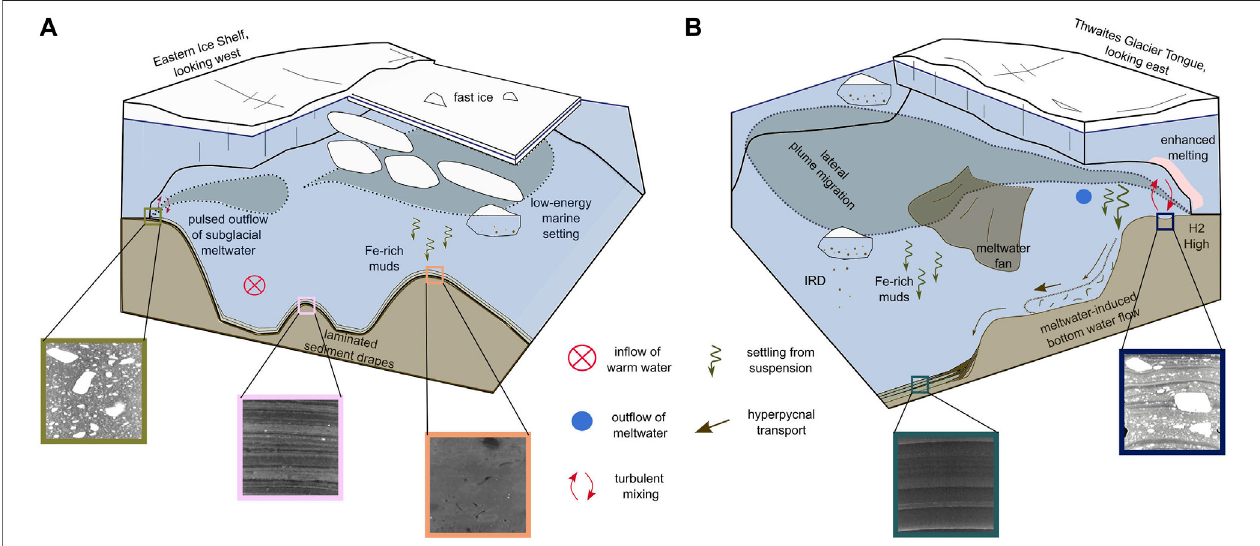
FIGURE 9 | Cartoon of contrasting meltwater drainage styles inferred offshore from the EIS and TGT. Callouts show general depositional settings, not exact locations, of sediment facies presented in Figure 6 . Grounding-line positions are not exact. (A) Persistent, low-magnitude drainage emanating from beneath eastern Thwaites Glacier. Settling from suspension dominates here, likely beneath a perennial canopy of fl oating ice. (B) Downslope gravitational transport sourced from sediment-laden meltwater plume deposits. Hyperpycnal fl ow delivers coarse silts and occasionally fi ne sands to trough, where fi ne silts and clays settle from